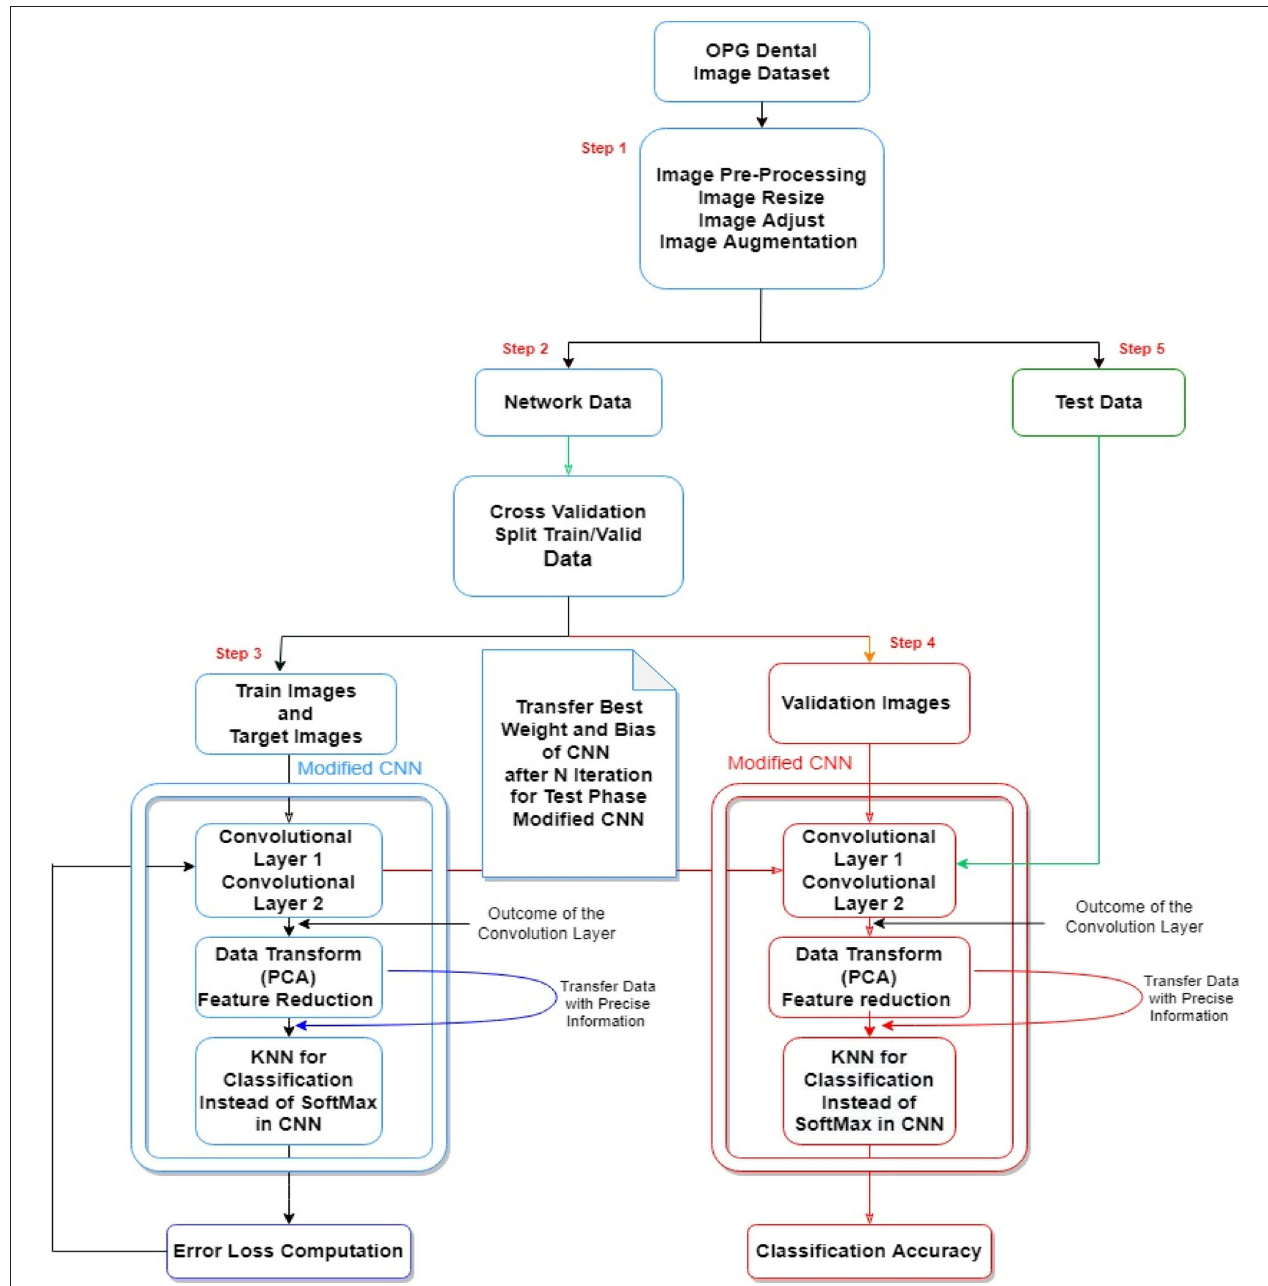
FIGURE 2 | The conceptual framework for our hybrid model, dental image processing and classification